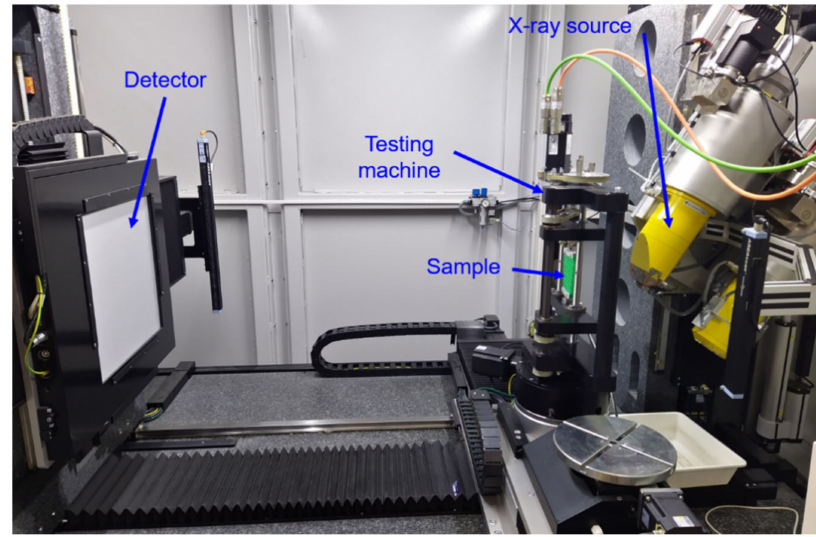
Figure 22. In-situ CT equipment (RIF e. V. Dortmund,